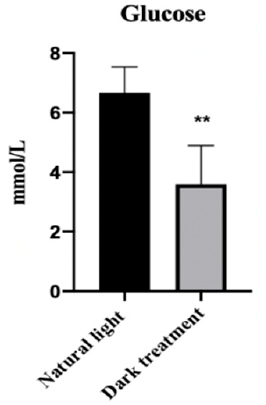
Figure 6. Effects of dark treatment on serum glucose concentration in L. vannamei. Values are represented as mean ± SD ( n = 4) by vertical bars. Bars assigned with asterisk ** are significantly different ( p < 0.01).